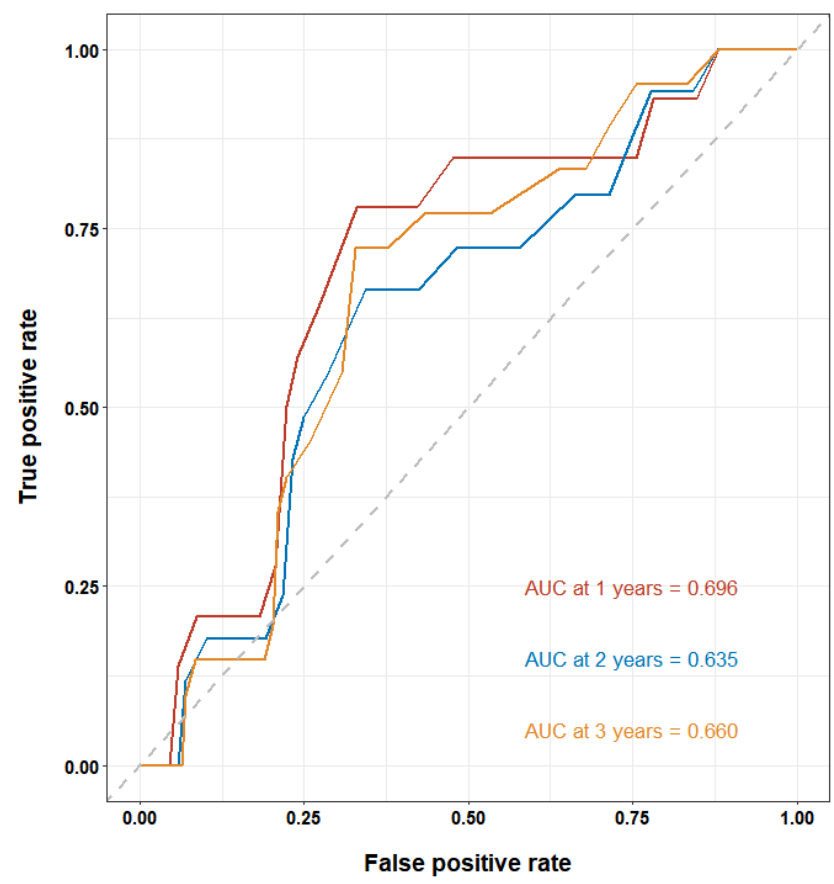
Figure 5. Time-dependent ROC curves of LAD for predicting thrombotic risk.